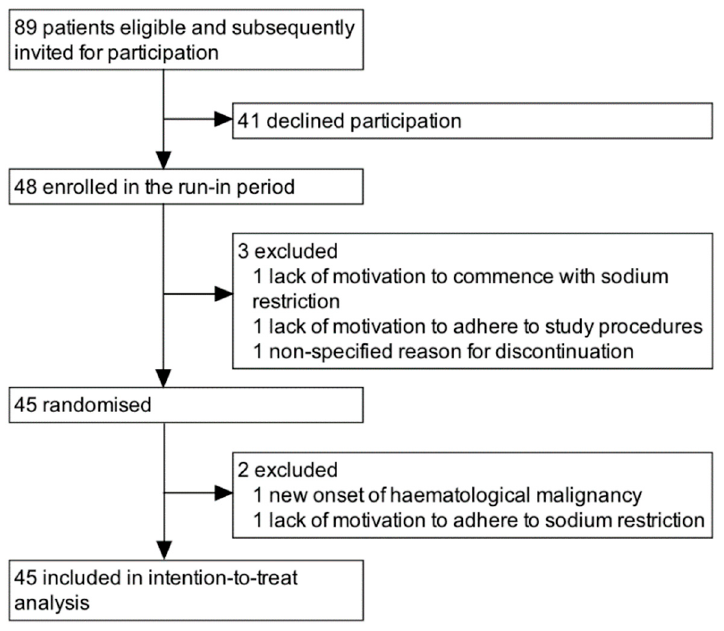
Figure 1. Participant flowchart.